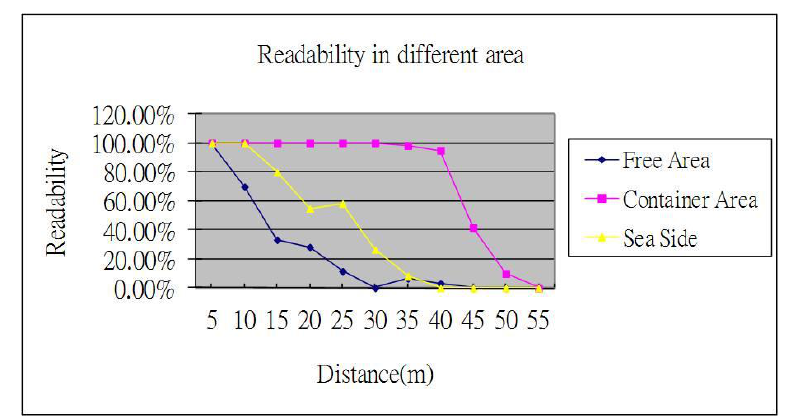
Figure 9. Relationships between Readability and Distance in different area